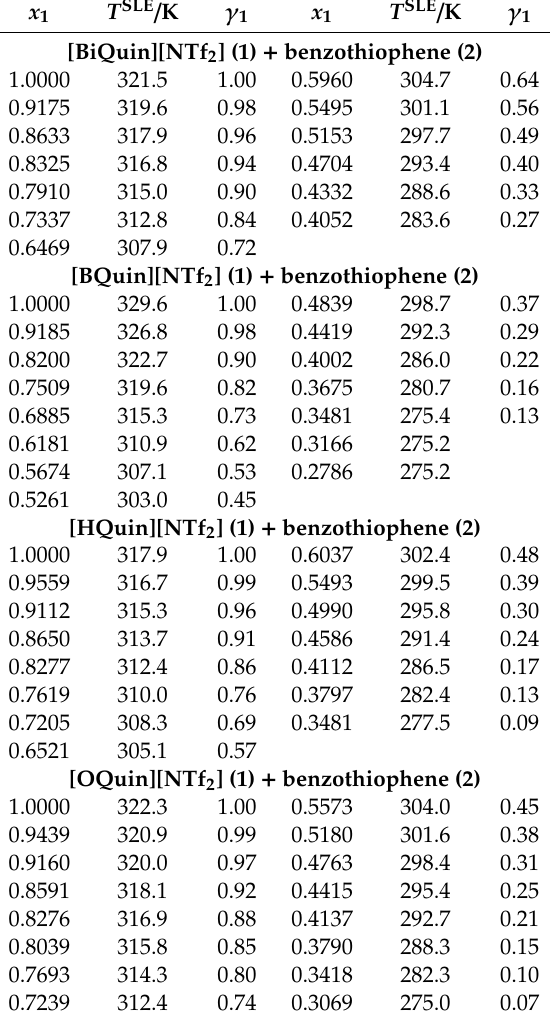
Table 2. Experimental (solid + liquid) phase equilibrium data, SLE, for {IL (1) + benzothiophene (2)} binary systems at pressure p = 0.1 MPa: x 1 is the ionic liquid mole fraction; T SLE is the equilibrium temperature; γ 1 is thee activity coe ffi cient of the IL obtained with the NRTL equation a,b . x